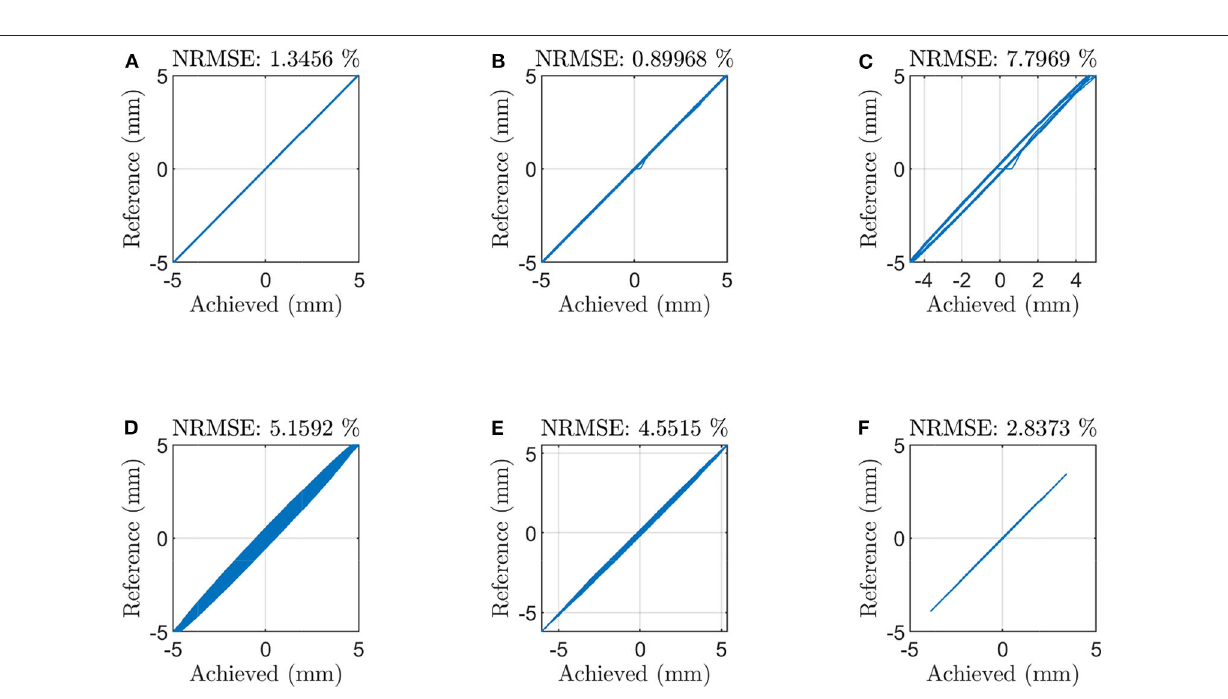
FIGURE 11 | Synchronization plots between the delayed reference ( 1 50) and achieved signals during open loop adaptive inverse control simulations. (A) sinusoid = at 1 Hz, (B) sinusoid at 20 Hz, (C) sinusoid at 40 Hz, (D) chirp with linear frequency increase between [0,10] Hz, (E) zero-mean Gaussian white noise low pass filtered at 15 Hz, and (F) structural response of DOF x 1 for the El Centro earthquake (40% scaling).